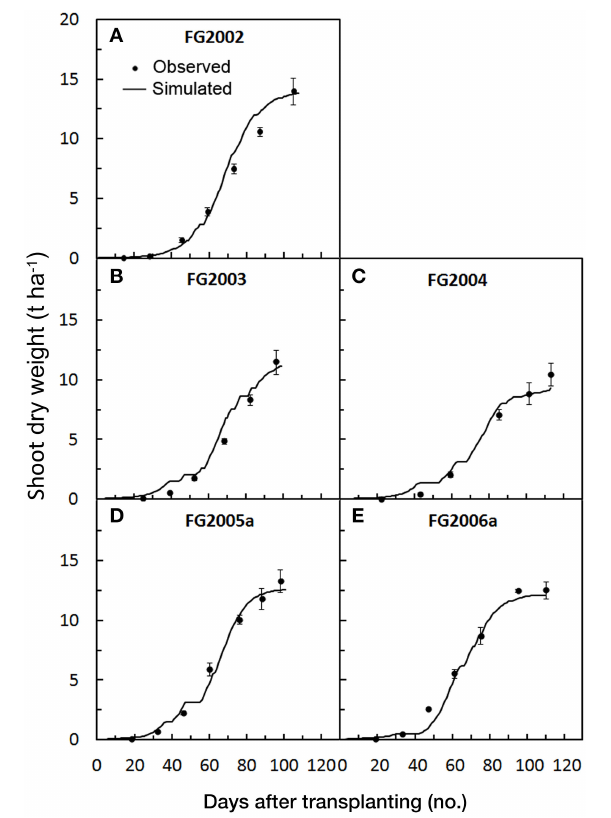
FIGURE 1 | Simulated and observed SDW accumulation during the growth cycle of the five tomato trials [FG2002 (A), FG2003 (B), FG2004 (C), FG2005a (D), and FG2006a (E)], used for calibrating GesCoN . Mean standard errors, when larger than the symbol, are represented by vertical